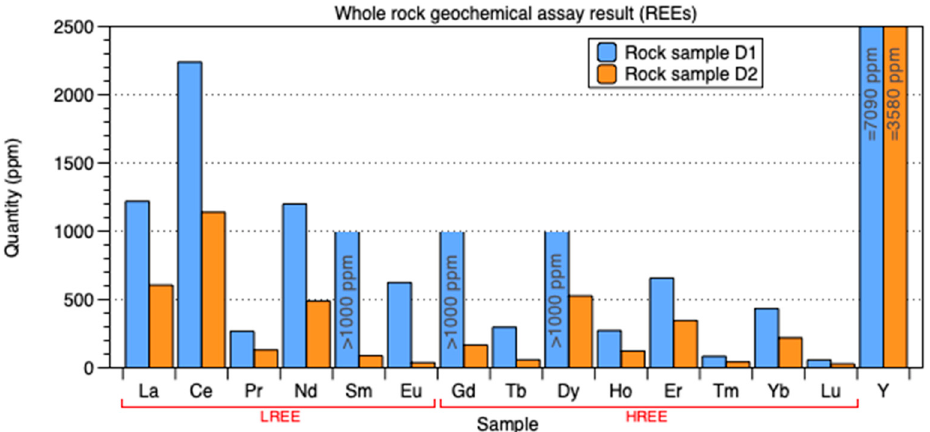
Figure 15. ICP-MS results of the rock samples taken in the field from both types of dykes; D1 and D2. Graph showing the highest amounts of major elements within each rock sample. Dyke 1 contains a higher amount of iron but less calcium than Dyke 2.